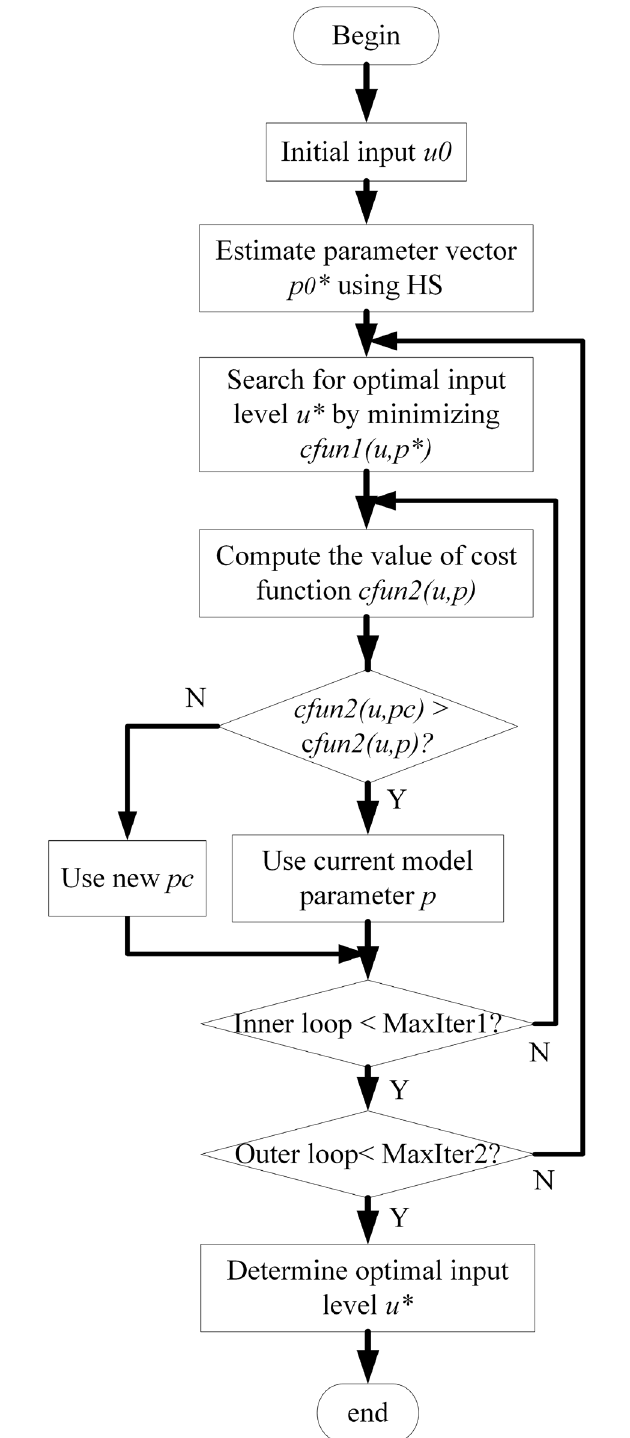
Fig 1. The flow chart of harmony search-based OED using a double nested loops. The inner loop updates the parameter vector based on an initial model parameter vector and the outer loop aims to determine the optimal input level u � by minimizing the cost